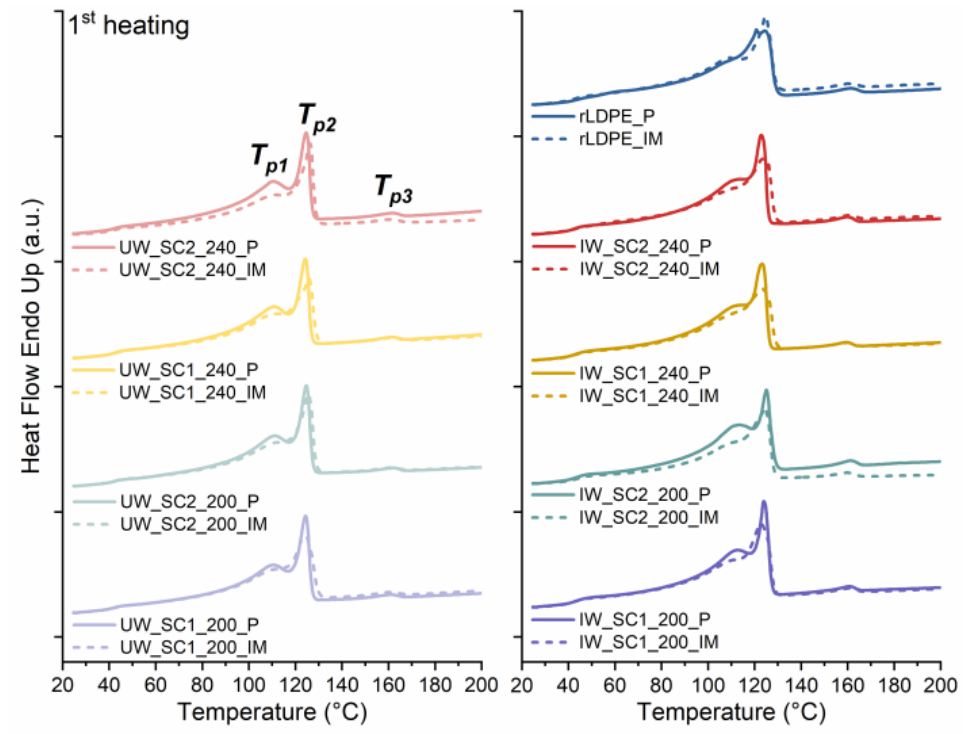
Figure 3. The first heating curves of the samples. The light colors show the unwashed samples and the dark colors show the industrially washed and/or recycled samples, where the pellets (P) after compounding are represented by dashed curves and the injection-molded samples (IM) by solid curves.